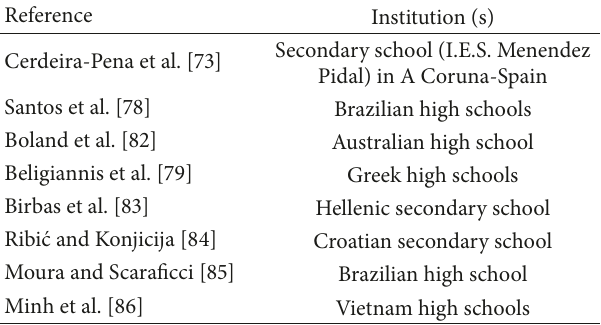
Table 8: Summary of real-world school timetabling datasets from different